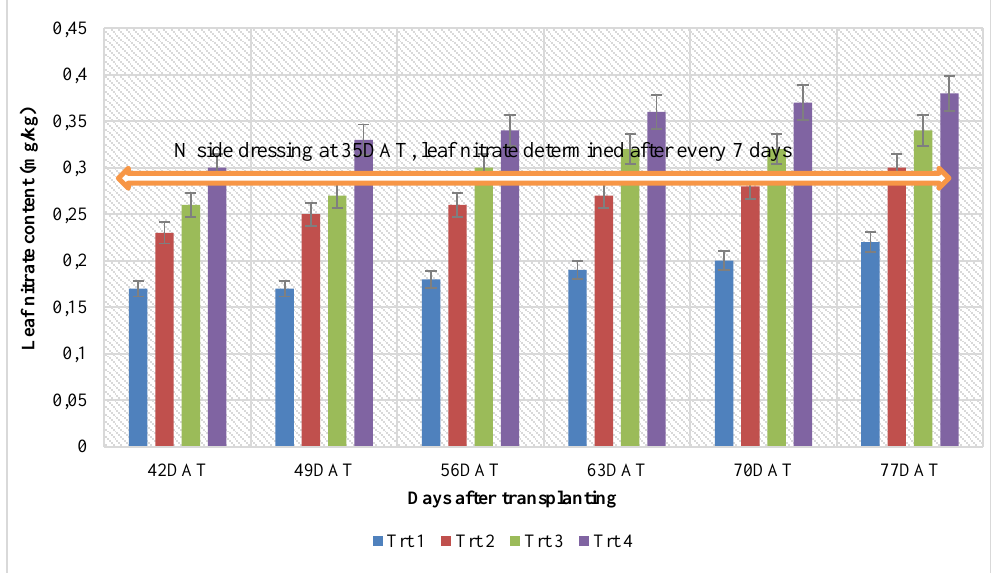
Figure 4b . Leaf nitrate content responses over the leaf harvesting period after N fertilizer application (2015)